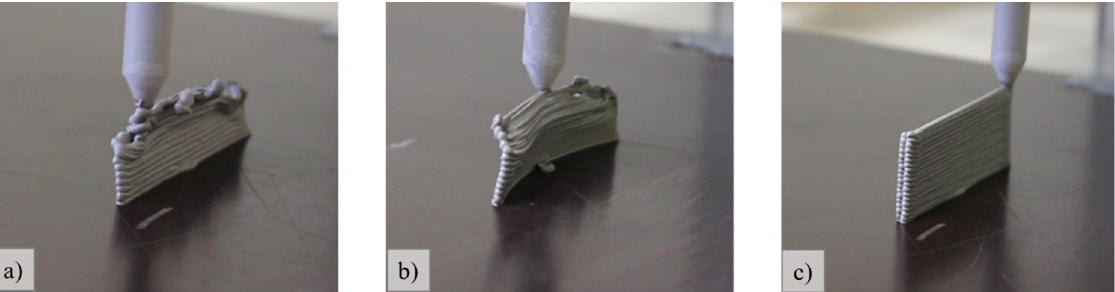
Table 3. Print parameters of the tested digital models in Figure 2.